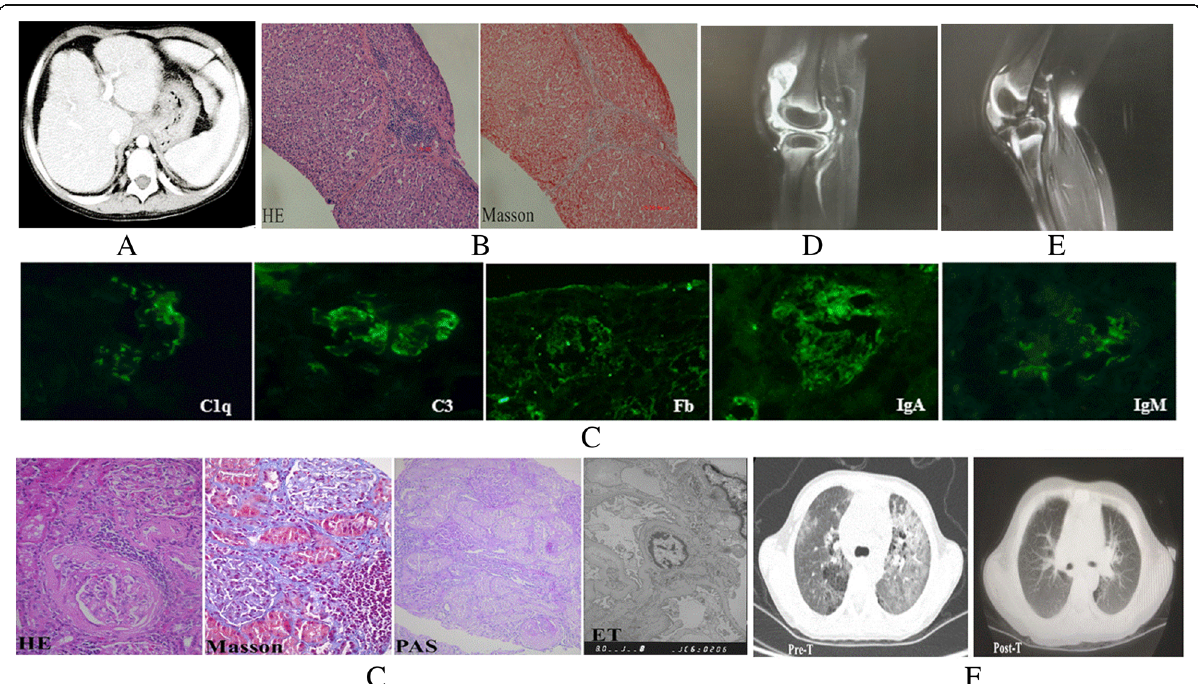
Fig. 2 a Abdominal contrast-enhanced MRI revealed hepatomegaly and hepatic fibrosis in P1. b Liver biopsy showed hepatic fibrosis by HE and Masson stain (× 200) in P1. c Renal biopsy showed lupus nephritis type III under light (× 400), electron (× 11600) and Immunofluorescence (× 400)